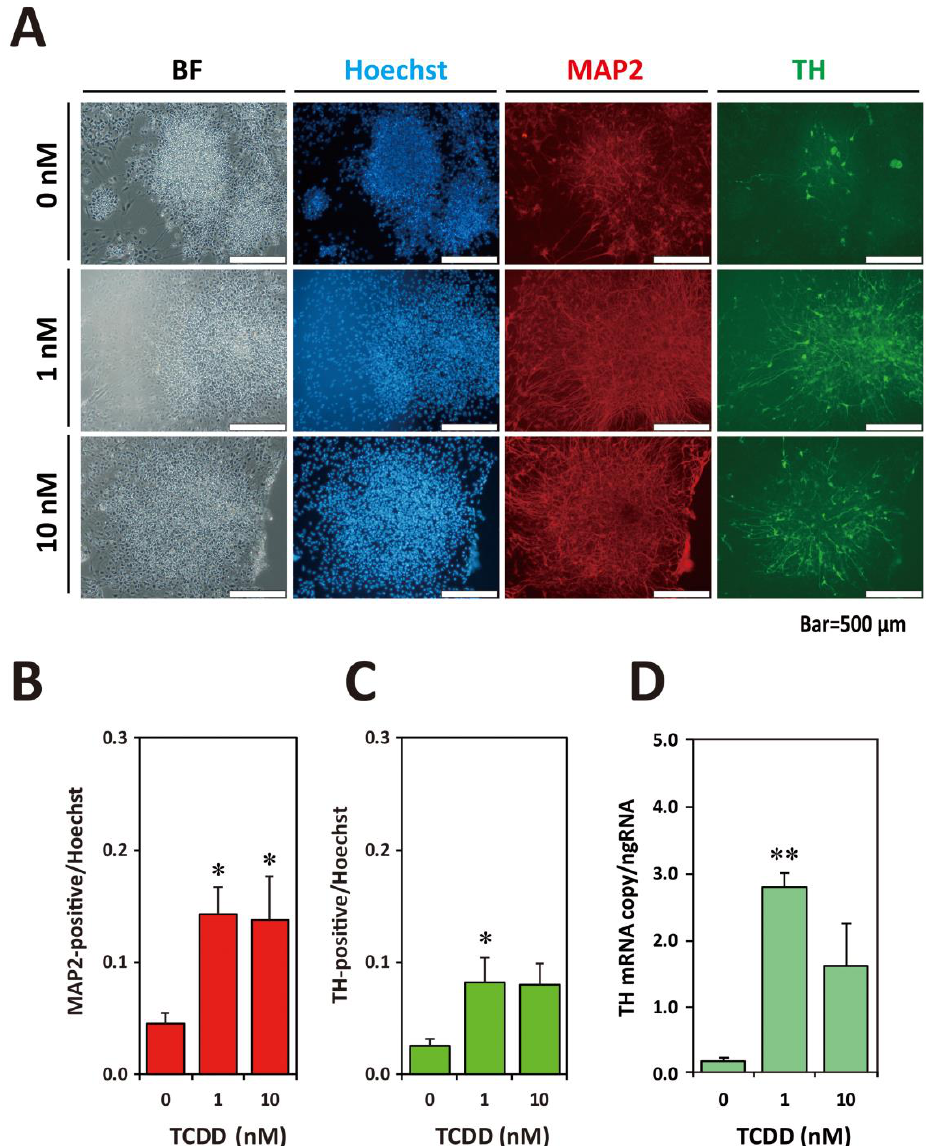
Figure 6. Effects of TCDD exposure on neural cell differentiations. ( A ) ICC on Day60 of the differentiated cells derived from KhES1rTHEGFP. During neuronal differentiation culture, the cells were exposed to TCDD (0, 1, and 10 nM) from Day9 to the end of culture (Figure 5A). BF, Bright-field; Hoechst, nucleus stained with Hoechst 33342; Red, MAP2 immunostaining; Green, TH-immunostaining. ( B ) MAP2-positive cell number. ( C ) TH-positive cell number. Data are expressed as mean ± SE ( N = 5–6). ( D ) RT-qPCR analysis of TH mRNA expression levels. Data are expressed as mean ± SE ( N = 3). One-way ANOVA was carried out followed by Dunnett’s test as post hoc (*, p < 0.05; **, p < 0.01).